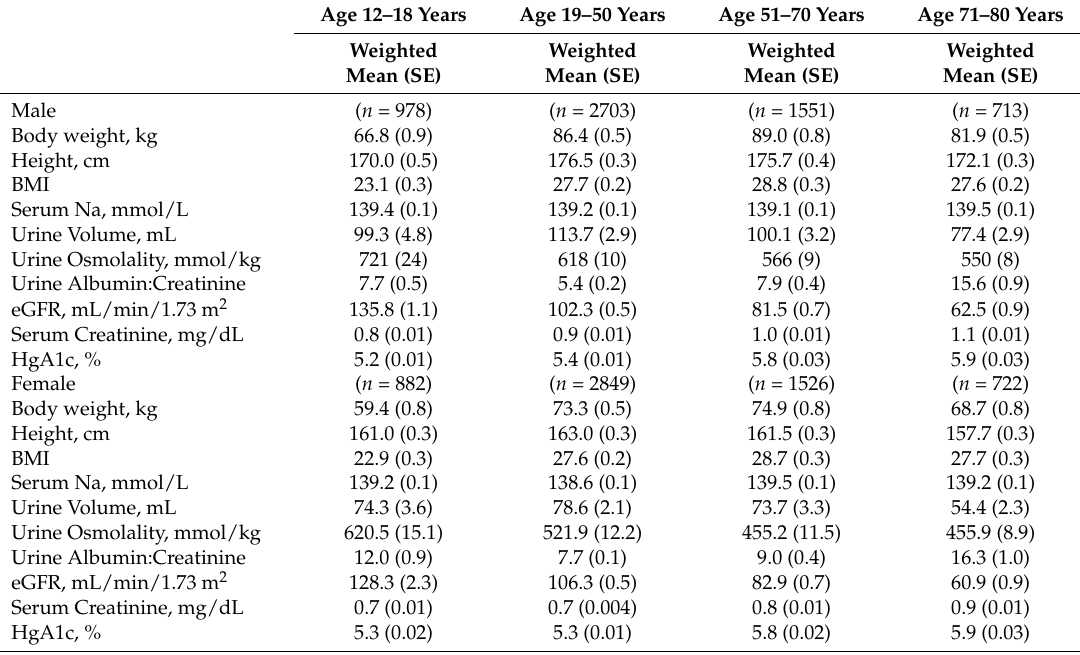
Table 1. Characteristics of the US population aged 12–80 years in